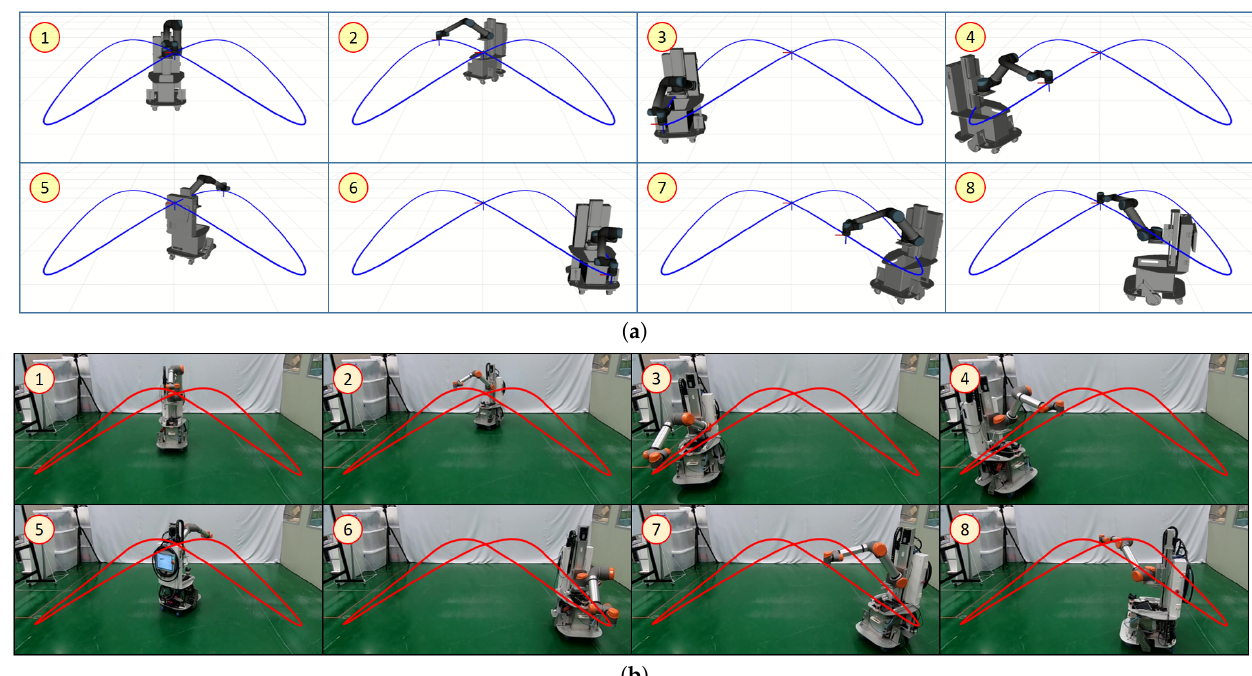
Figure 6. Snapshots of the NMM’s motion for the Lissajous trajectory tracking: ( a ) simulations; and ( b )